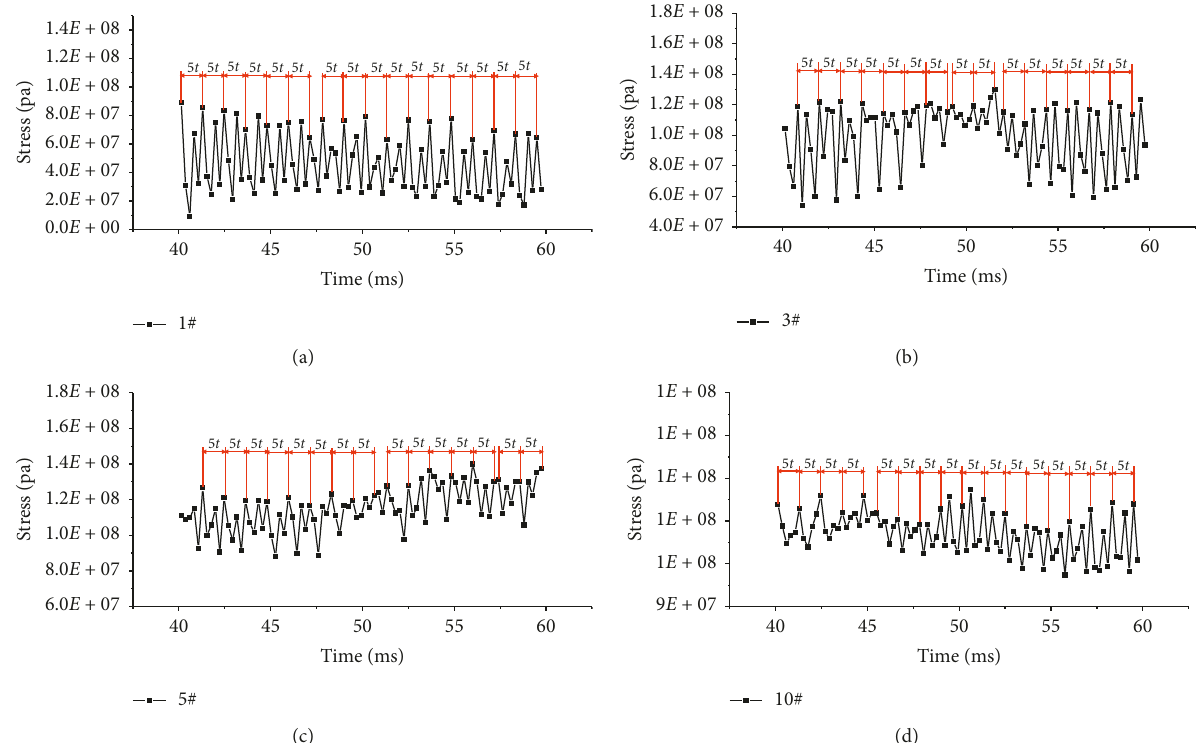
Figure 7: Stress fluctuation cycle period of the representative elements ( α � 20 ° , H � 10mm, and V � 1.36m/s): (a) 1# element; (b) 3# element; (c) 5# element; (d) 10# element.